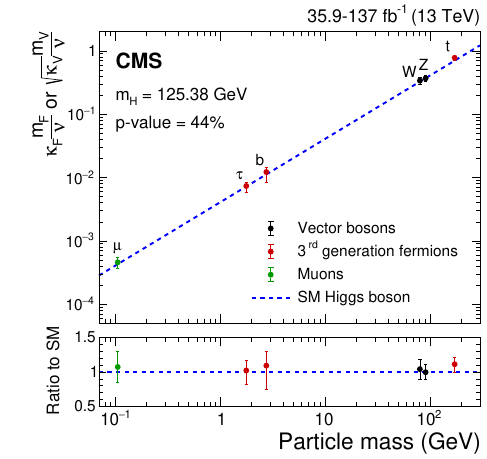
for m = 125 . 38 GeV, µ H is 1.07 µ < 1 . 29 . Right: the best fit estimates µ